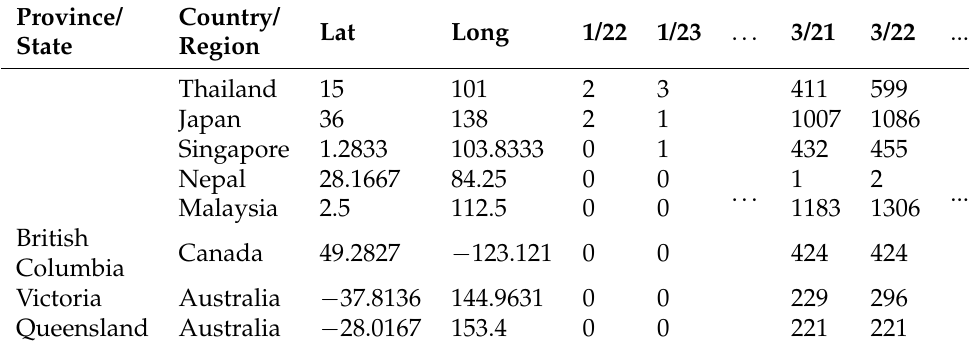
Table 3. An example of the data contained in the JHU